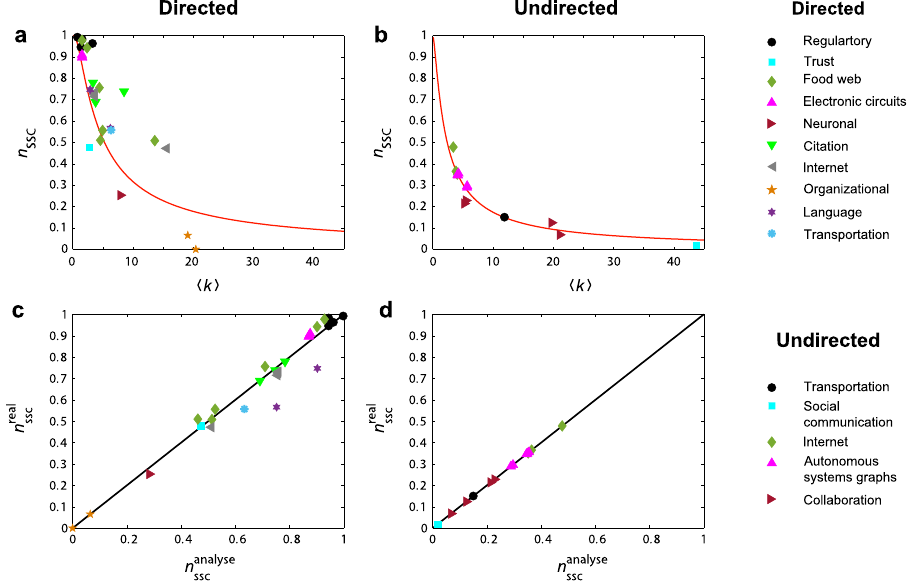
Figure 5. Strong structural controllability of real-world networks. ( a , b ) Strong structural controllability measure n ssc as a function of the average degree 〈 k 〉 for real directed and undirected networks, respectively. ( c , d ) Numerically calculated n sscreal and theoretical prediction n sscanalyse , respectively. In ( a , b ), the curves represent analytical results of a model network with an exponential degree distribution (see Supplementary Notes 7 and 8 for the analytical